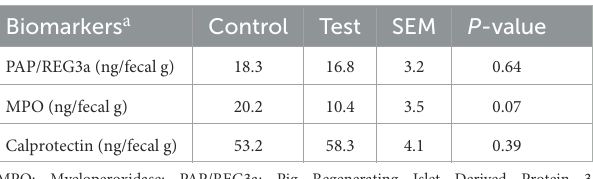
TABLE 8 SCFA composition in the small intestine (last 25%), caecum and colon of piglets at d14 post-weaning, when fed a control diet (Control; n = 10) or a diet containing 2 kg/ton specific fiber fractions derived from Araceae root and citrus (Test; n = 10) from d0 to d14 post-weaning.